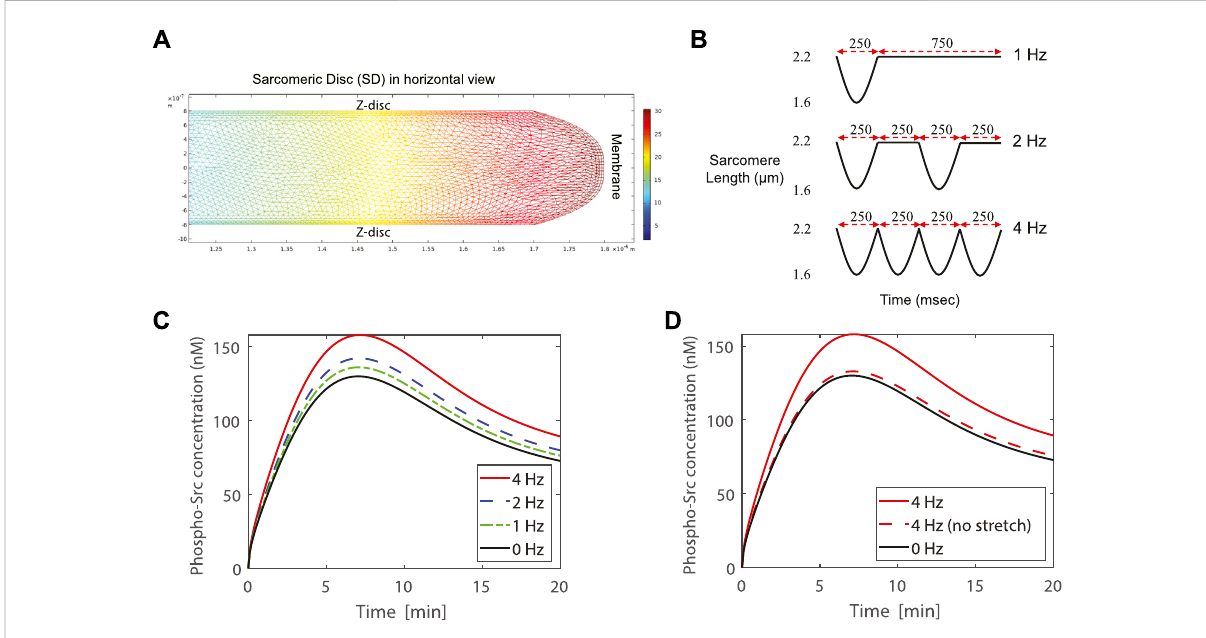
FIGURE 5 (A) The concentration of phospho-Src in the cytosol of one SD in the 4 Hz case at 25 s after PDGF stimulation. The SD is shown in horizontal view. (B) Contraction pro fi les of the modeled SD for 1, 2, and 4 Hz contraction frequency. (C) Simulation of acontracting SD, by modeling the lattice expansiontogetherwithmembranestretch,exhibitshigherconcentrationofphospho-SrcwhenSDbeatswithhigherrates.Simulationsshow21.5%, 9.4%, and 4.7% higher concentration of phospho-Src, respectively at 4, 2, and 1 Hz contraction frequencies, comparing to 0 Hz. (D) The dashed-red curve represents a case in which the lattice expansion completely compensates the cytosol displacement and there is no membrane stretch. In this case the peak value of the phospho-Src concentration is only 2.2% higher than the peak value of the 0 Hz case. Simulations demonstrate that membrane stretch has higher impact than lattice expansion in increasing the phospho-Src concentration. The lattice expansion with membrane stretch study are presented in dashed curves. The solid curves show the lattice expansion without membrane